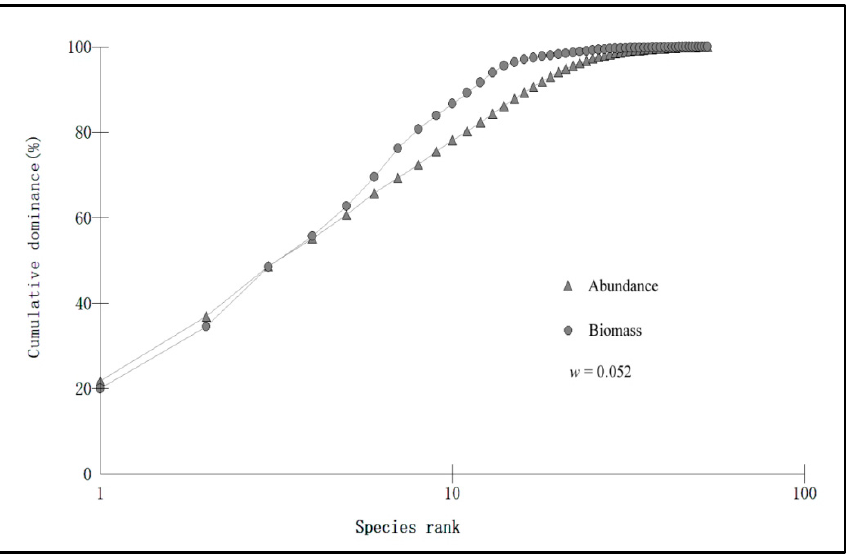
Figure 3. The abundance-biomass curve (ABC) of fishes in the midstream of the Jialing River sam- pled from December 2021 to November 2022. from December 2021 to November